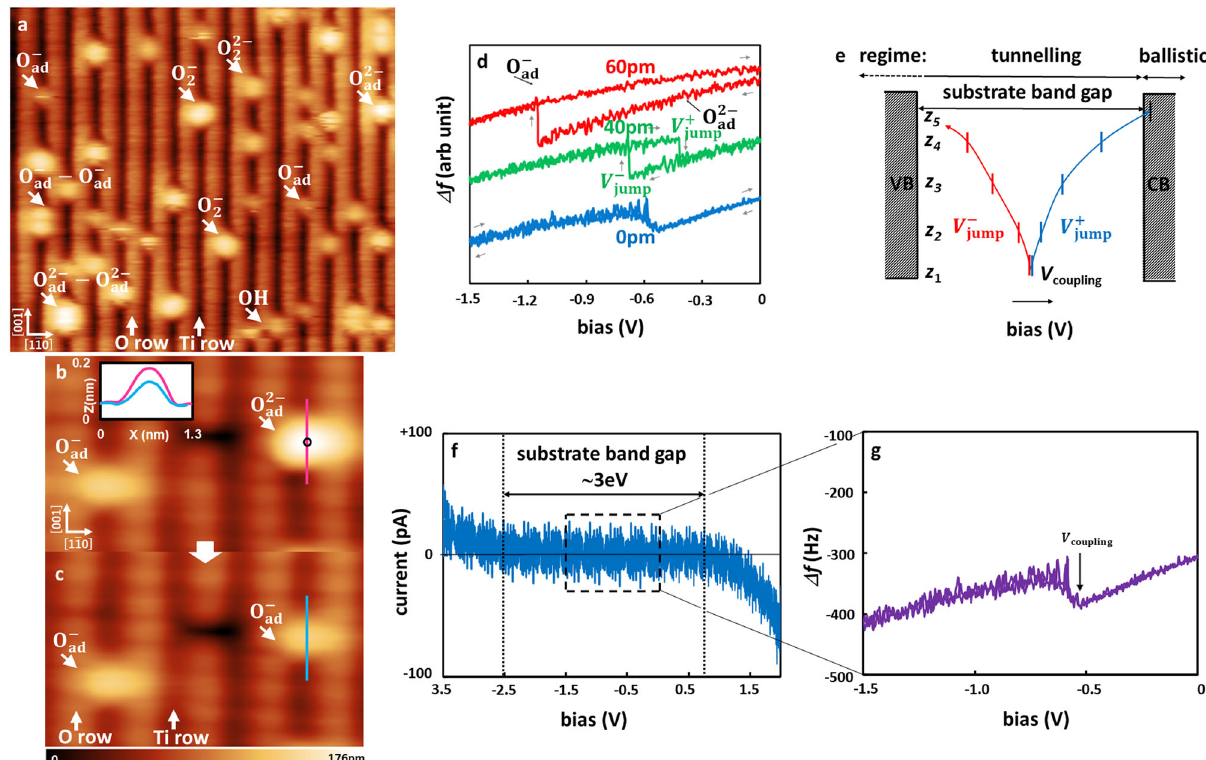
Fig. 1 Various O atom species on the TiO 2 surface and their charge manipulation at 78 K. a Large-scale image of the TiO 2 surface showing different oxygen species identi fi ed by spectroscopy: adatoms O (cid:1) ad , O 2 (cid:1) ad ; pairs of adatoms O 2 (cid:1) ad --O 2 (cid:1) ad , O (cid:1) ad --O (cid:1) ad ; molecules O 2 (cid:1) (hydroxyl group). High-resolution AFM images of an O atom before ( b ), as O 2 (cid:1) ad ) and after ( c ), as O (cid:1) ad ) charge manipulation. Inset in ( b ): the corresponding line scans across the two species. d Results of typical KPFS manipulations with the tip positioned as indicated by a black circle in ( b ), at three heights as indicated. Each such manipulation leads to image ( b to c ) transformation. e Schematic sketch of positions of the occupied O 2 − p -orbitals responsible for the oxidation process ( V (cid:1) jump , full red lines) and of the unoccupied O − p -orbital responsible for the reduction process ( V þ jump , full blue lines) relative to the substrate band gap (VB/CB valence/conduction band) as a function of tip-sample distance z ( z 1 < z 2 < ⋯ < z 5 ), and bias voltage. f Tunnelling current vs. bias voltage taken above TiO 2 surface. g Frequency shift vs. bias voltage observed at close approach over an O atom, which is the same height as the blue curve in d